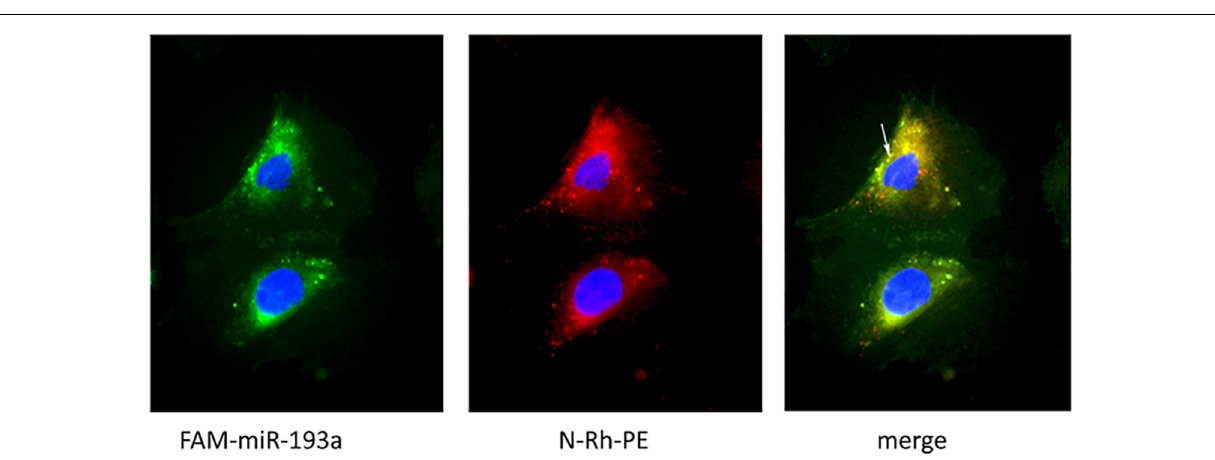
FIGURE 6 | Visualization of exosomes shuttling FAM-labeled miR-193a-5p to recipient podocytes. Recipient podocytes were incubated with donor podocytes-derived exosomes (10 µ g/ml). Yellow fluorescent “specs” (indicated by white arrow) represent N-Rh-PE labeled exosomes containing FAM-miR-193a-5p taken up by the recipient